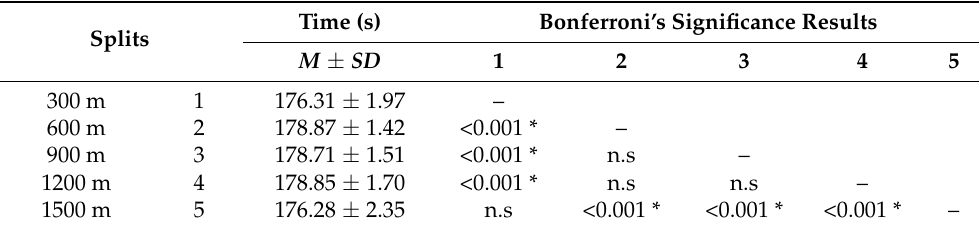
Table 3. Summarized post hoc Bonferroni’s and Scheff é ’s tests analysis of the 300 m split of the 1500 m swimming performance.